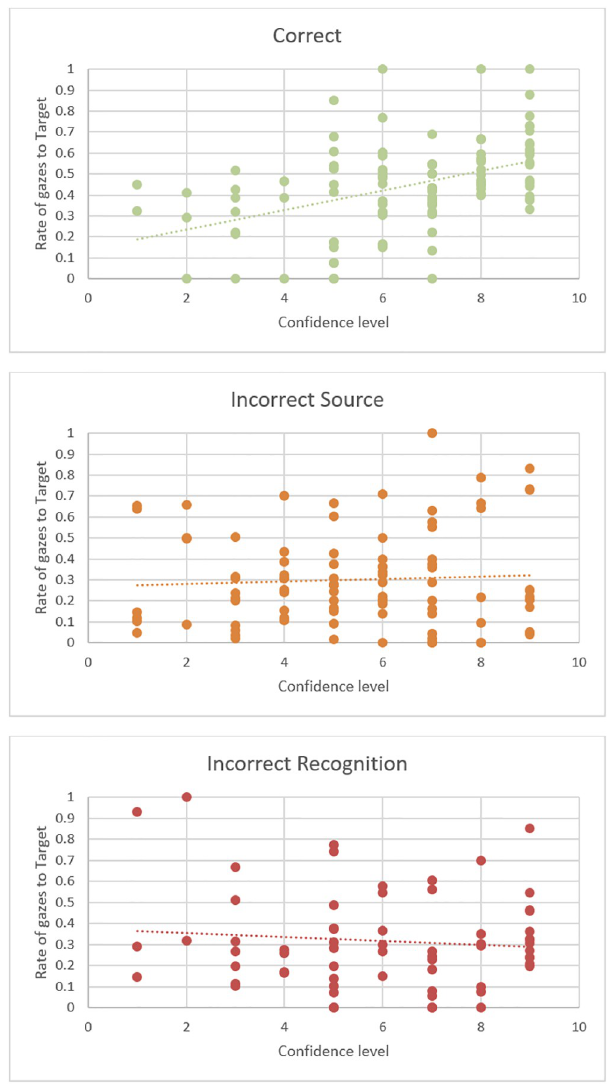
Fig 6. Relationship between confidence and gaze. When participants correctly identified the source location of a test cue, their reported confidence level correlated with time spent looking at the target. This relationship did not occur for test trials in which an incorrect response occurred. The graphs show the proportion of gaze samples falling on the target quadrant (averaged across relevant trials for each participant) for each of the response types as a function of reported confidence level in the location response (for Correct and Incorrect Source responses) or in the ‘new’ response (for Failed Recognition